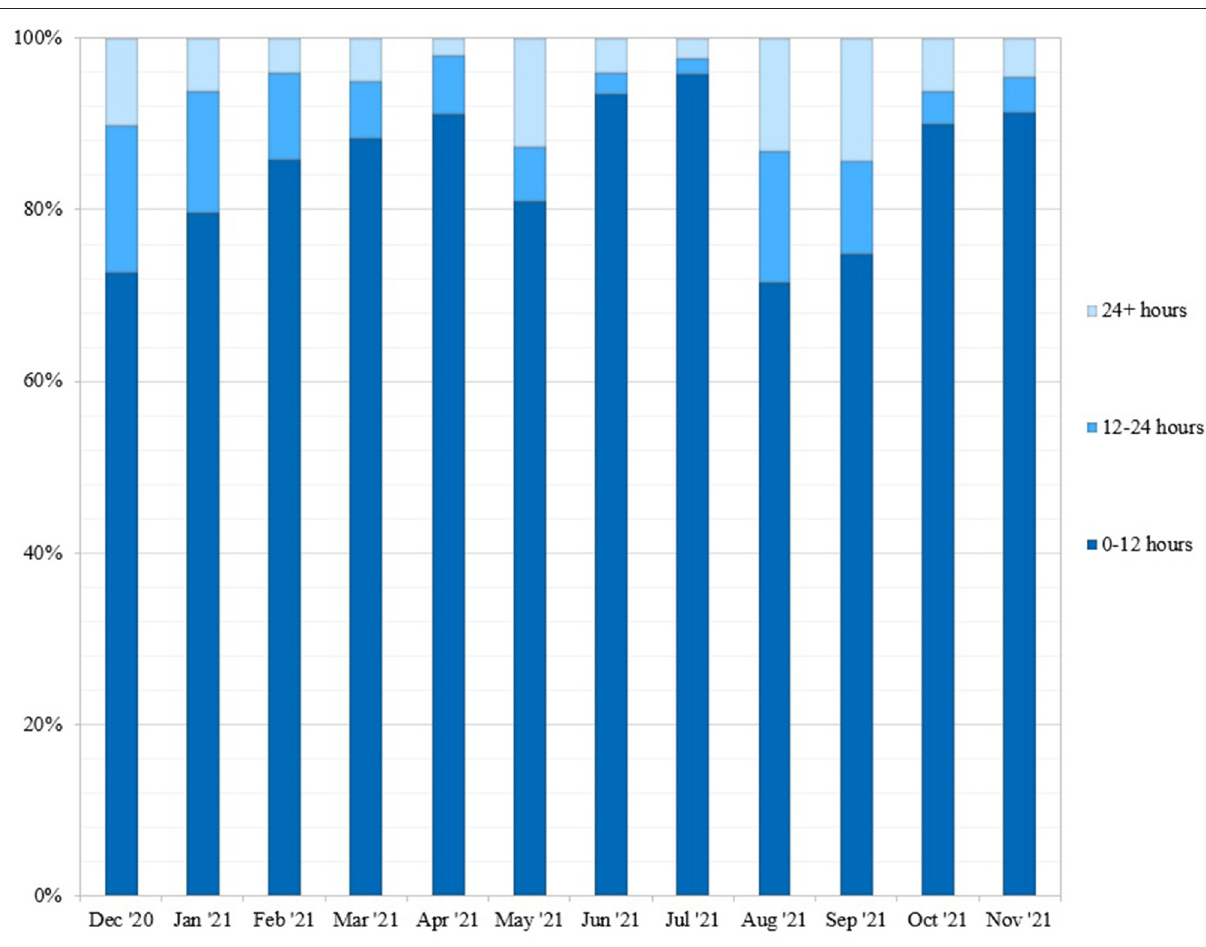
FIGURE 4 | Weekly turnaround time for community tests performed at REDDI Lab from December 1, 202096-November 30, 2021. Turnaround time was calculated by taking the difference between time of sample collection and time of result. This data was obtained from the clinical reporting platform (Rymedi, version 1.0, Greenville SC,